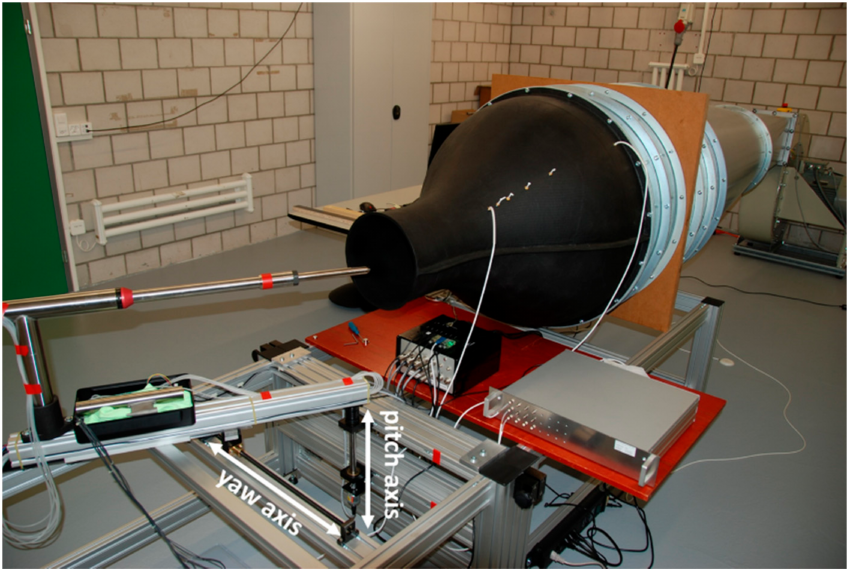
Figure 5. Wind tunnel calibration and testing environment for the 5-hole turbulence probe on a two-axis platform (provided by the manufacturer).